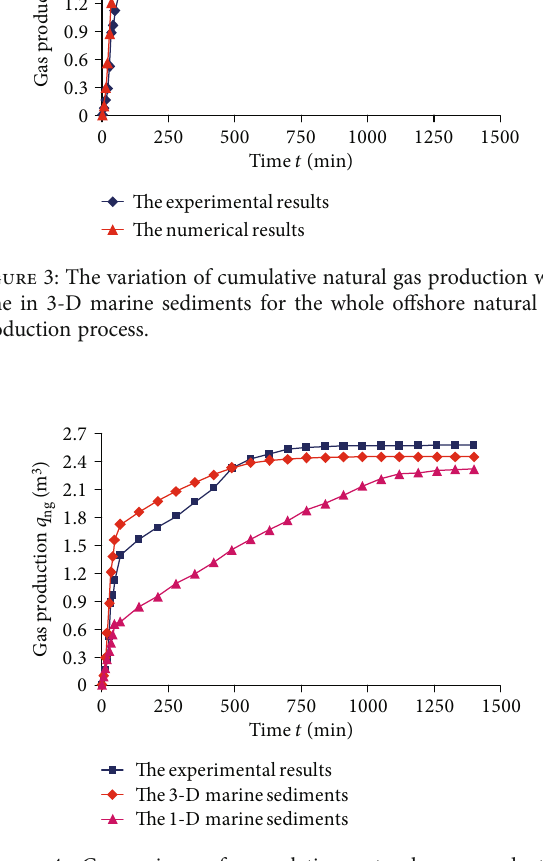
Figure 4: Comparison of cumulative natural gas production between the experimental and numerical results for the 3-D model and the conventional 1-D model in marine sediments.